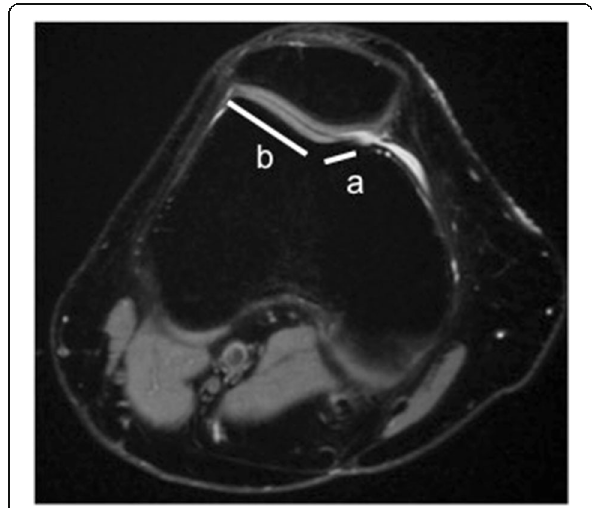
Fig. 3 Facet asymmetry assessment for trochlear dysplasia on axial MRI. It is the percentage of the medial ( a ) to the lateral ( b ) trochlear facet length (a/b ×